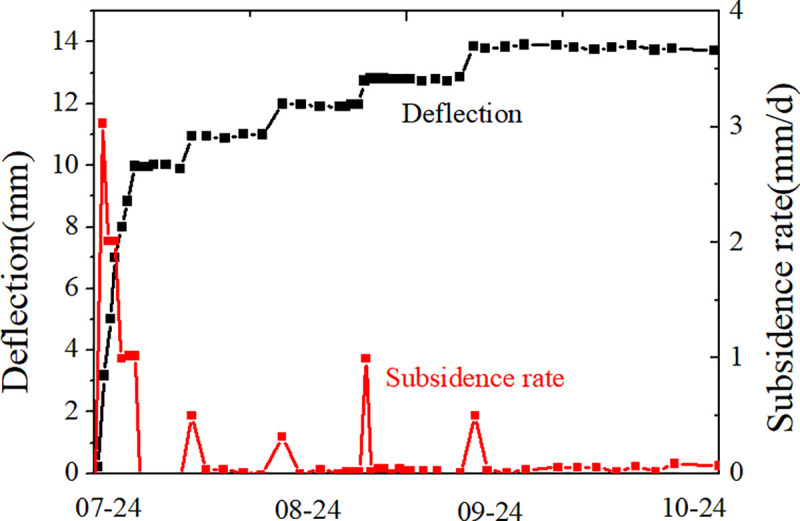
Curve of vault subsidence and change of subsidence rate.